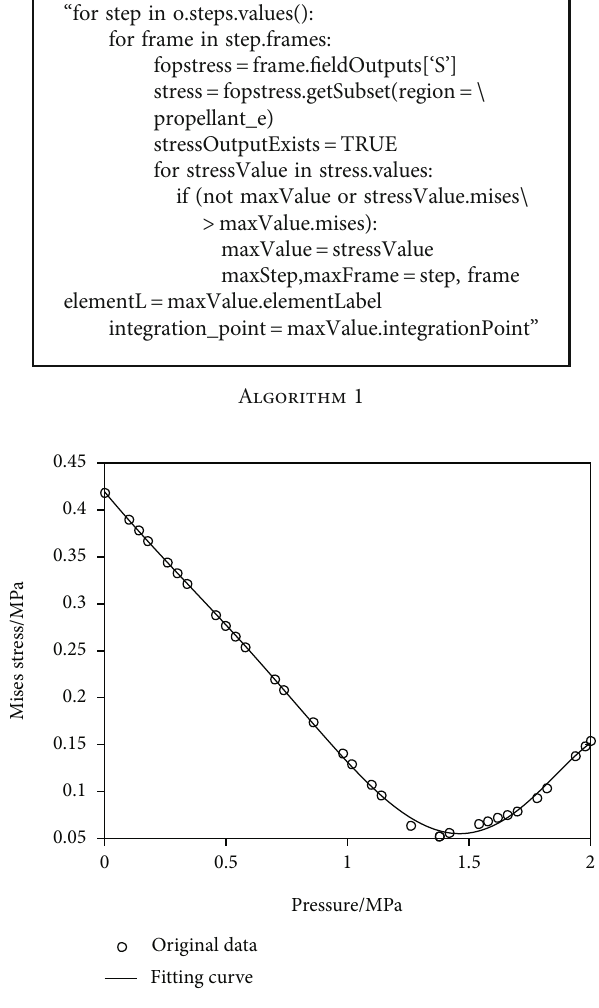
Figure 7: The variation of max Mises stress with pressure.